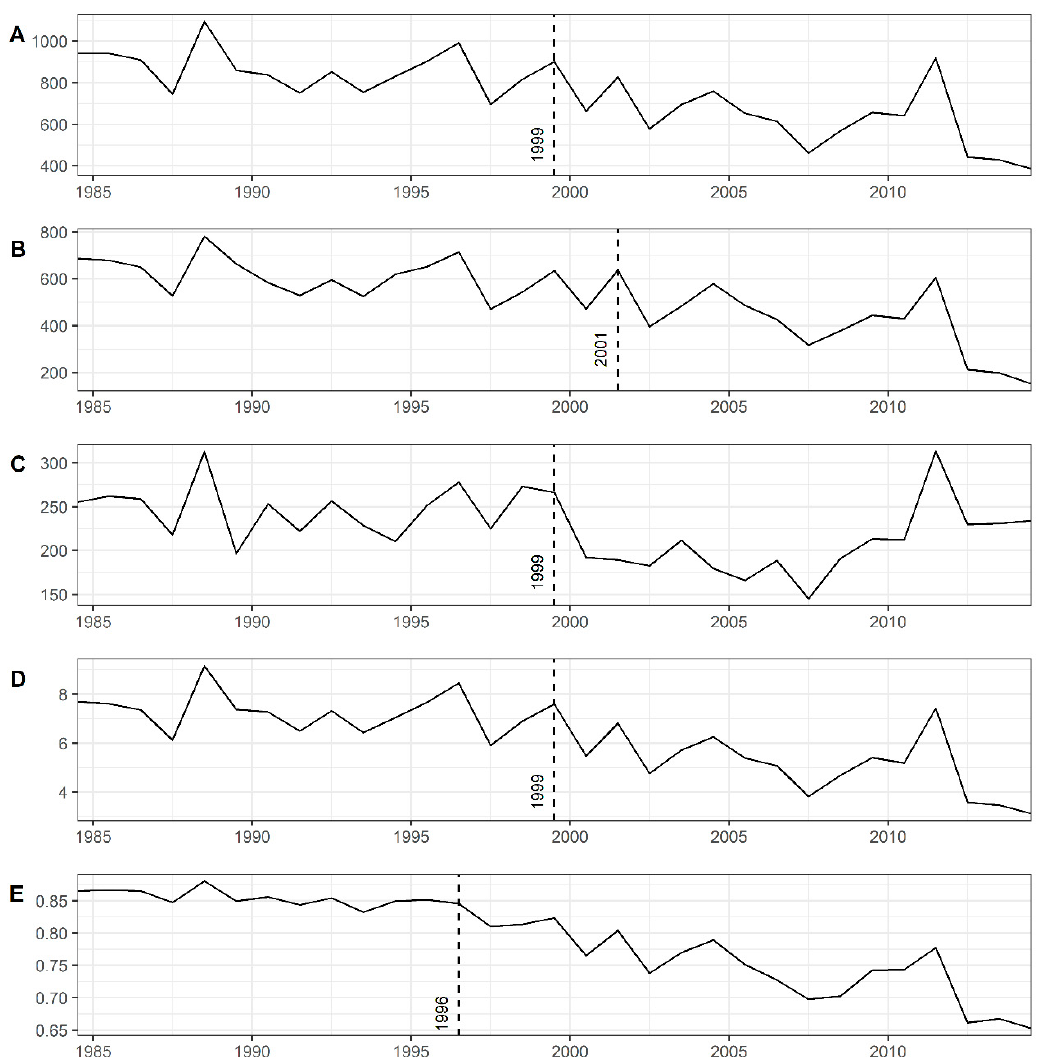
Figure 6. Change points for annual water use by agricultural counties from 1984 to 2014: ( A ) total, ( B ) surface water, ( C ) groundwater measured in thousands of acre-feet (000s AF); ( D ) per capita water use measured in acre-feet (AF); and ( E ) proportion of total water used.